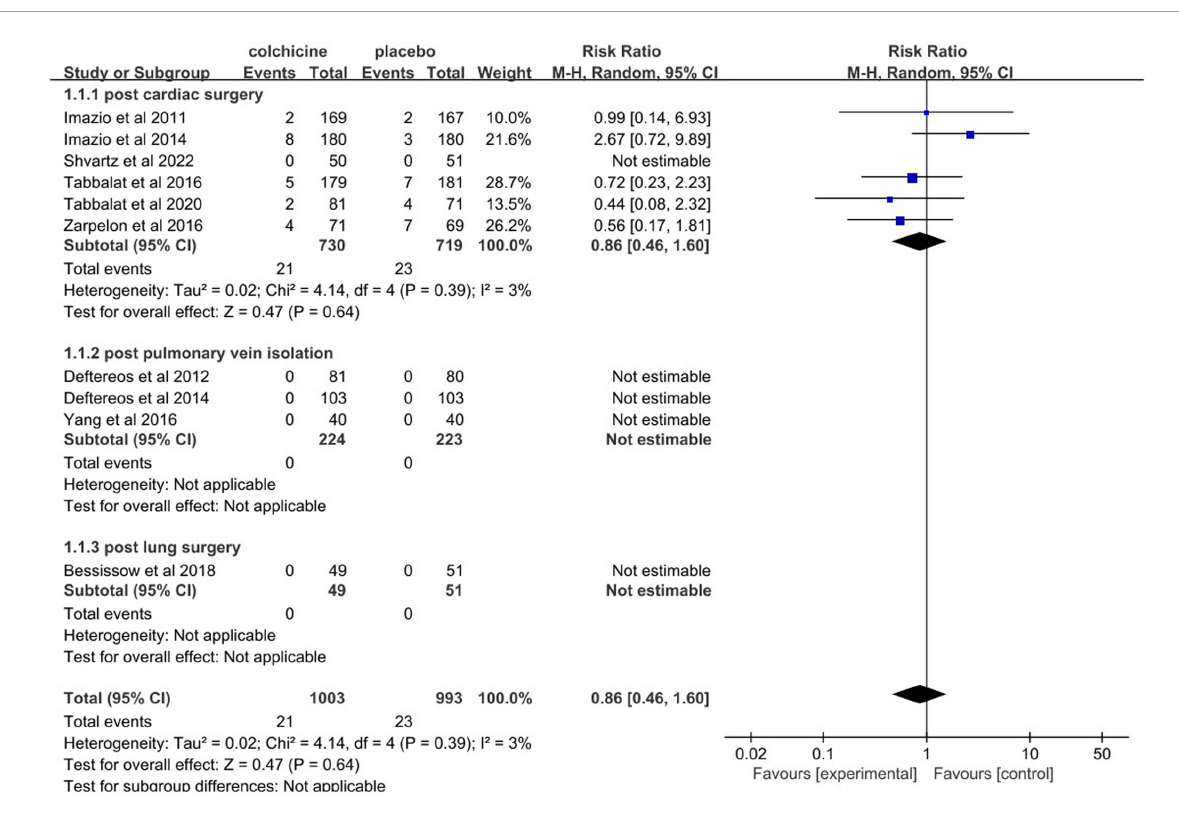
FIGURE11 Forest plot for overall risk of major adverse effects (all-cause death and